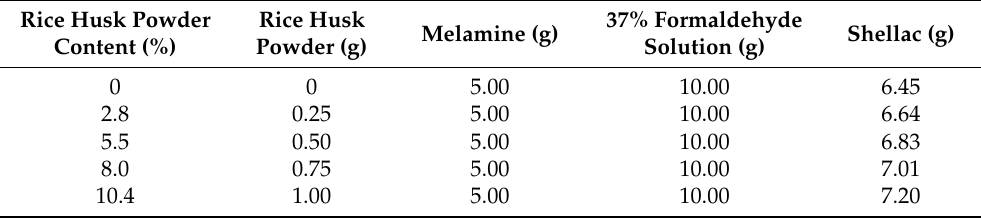
Table 4. List of consumption of each substance in the single-factor